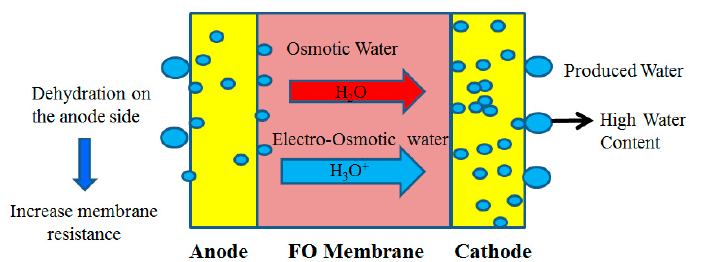
Figure 1. Water transmission in a forward osmosis microbial fuel cell.